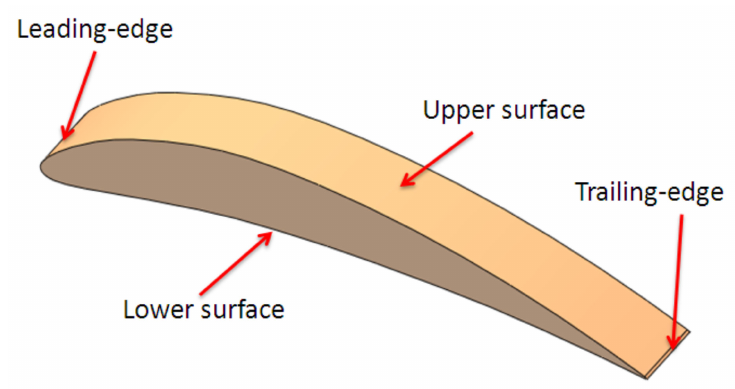
Figure 3. The very short-span wing model